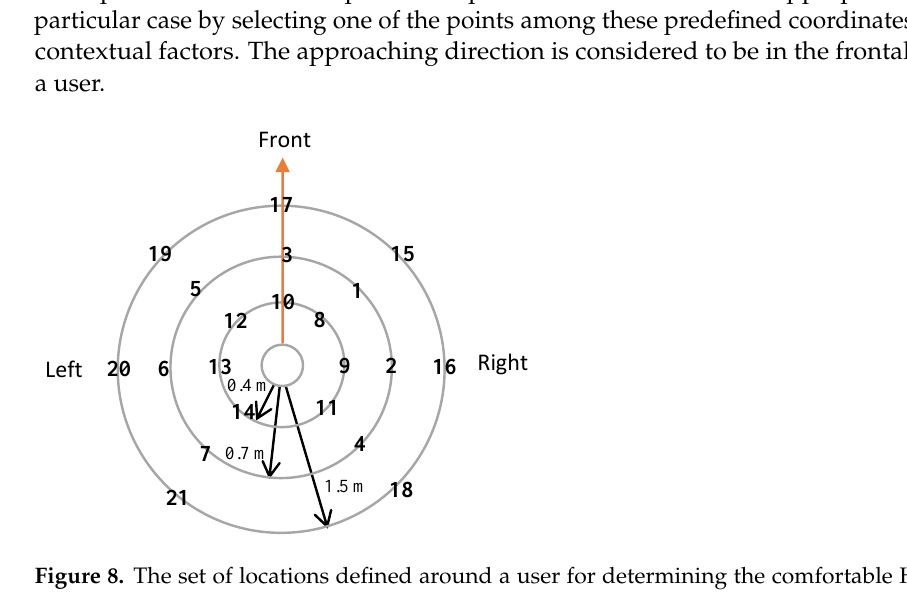
Figure 8. The set of locations defined around a user for determining the comfortable HRP by the poxemic planner proposed in [67].